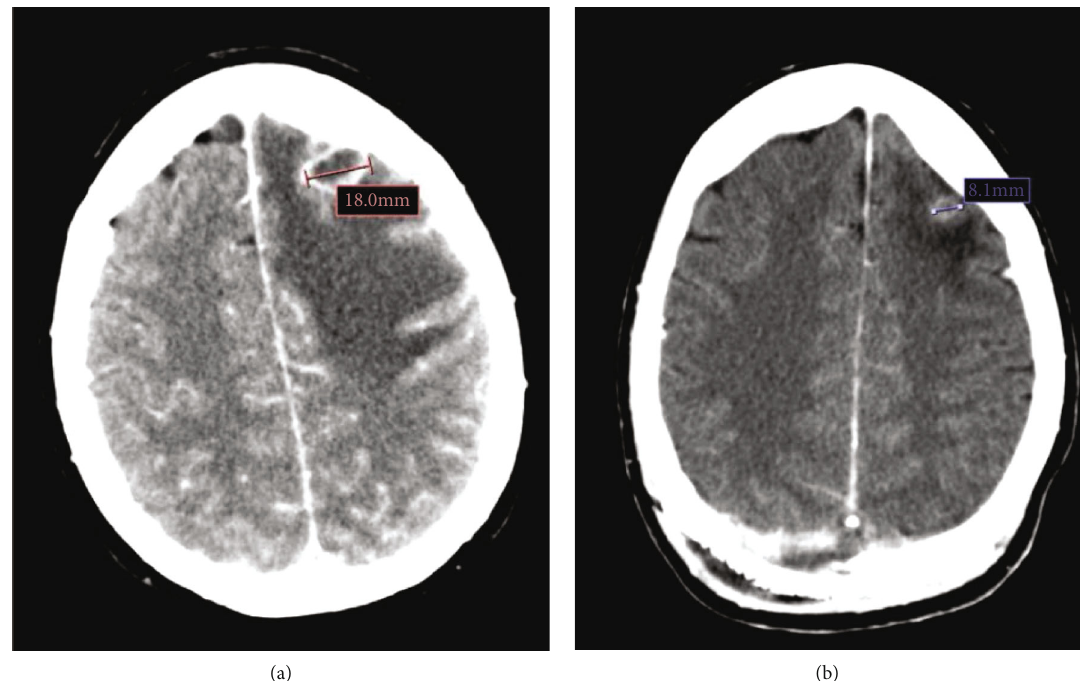
Figure 3: Image of left frontal lobe lesion from CT scan at diagnosis (a) and reevaluation CT scan performed six weeks after the initiation of osimertinib (b), showing a partial response (from 18 mm to